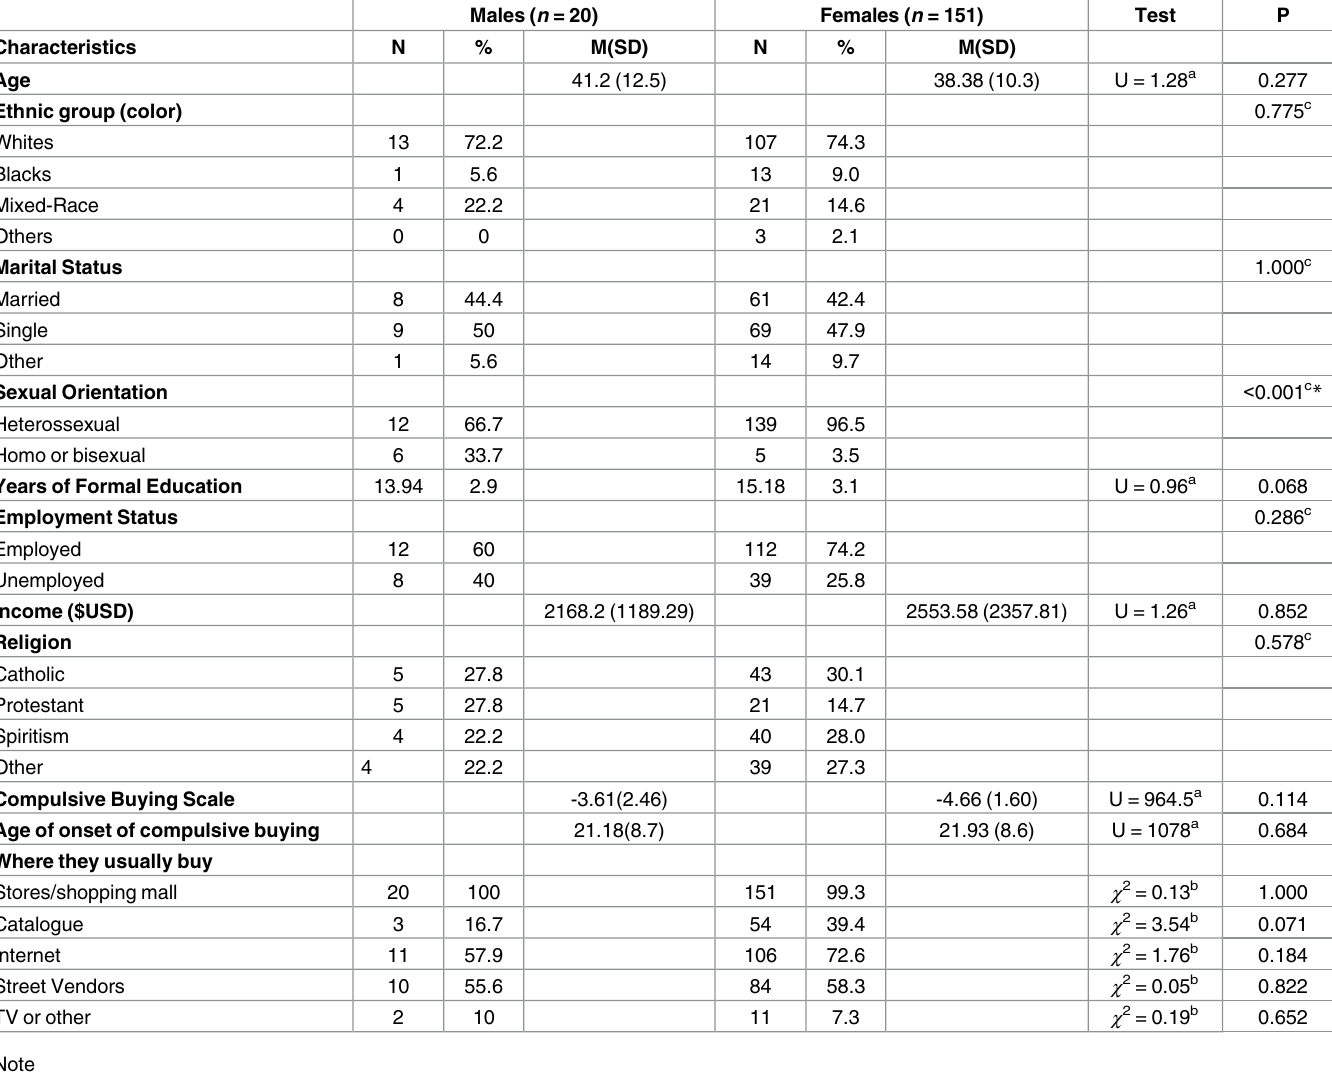
Table 1. Demographics and shopping behavior characteristics between male and female compulsive